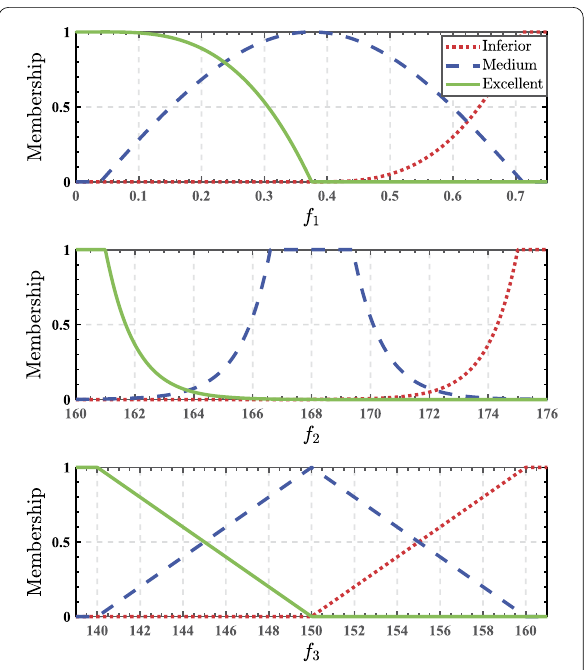
Figure 5 Membership functions of three